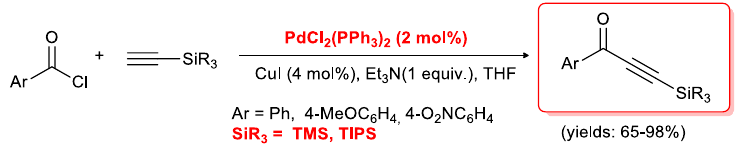
5 of 35 Figure 1. Rigid trans -spanning ligands used in Cu-free acyl Sonogashira protocol optimized by Sonoda et al. Benzoyl chloride and 1-octyne were chosen as standard substrates and tested in the presence of different solvents, bases and ligands. PdCl 2 (PPh 3 ) 2 (2 mol %), triethylamine (3.5 equiv.), 40 °C, toluene and 2-((2-(thiophen-2-ylethynyl)phenyl)ethynyl)pyridine (I) (2 mol %) resulted to be the best experimental conditions which were then used in the acyl Sonogashira coupling of various acid chlorides and terminal acetylenes. Aromatic derivatives were coupled effectively, affording the alkynones in high yields (73%–99%). Cyclohexanecarbonyl and pivaloyl chlorides were reacted with 1-octyne to give the desired product (76%–77%), while acetyl chloride was found unsuitable for this reaction. Alkynes with nitrile, cyclohenyl, hydroxyl and triisopropylsilyl moieties were used too and yielded the expected coupling products (71%–99%). 2.1.2. PdCl 2 (PPh 3 ) 2 Catalyzed Acyl Sonogashira Reactions of Silylated Alkynes The use of a silylated acetylene is particularly interesting, since the silyl group can be easily removed and the acetylene moiety can be submitted to several transformations. Indeed, Müller and co- workers reported the acyl Sonogashira reactions of trimethylsilylacetylene with (het)aroyl chlorides performed in the presence of PdCl 2 (PPh 3 ) 2 (2 mol %) and CuI (4 mol %) (Scheme 8) [23,24]. Both electron- donating and electron-withdrawing groups on the benzene ring were well tolerated, and the reaction between thiophene-2-carbonyl chloride and (TMS)-acetylene afforded the corresponding ynone in high